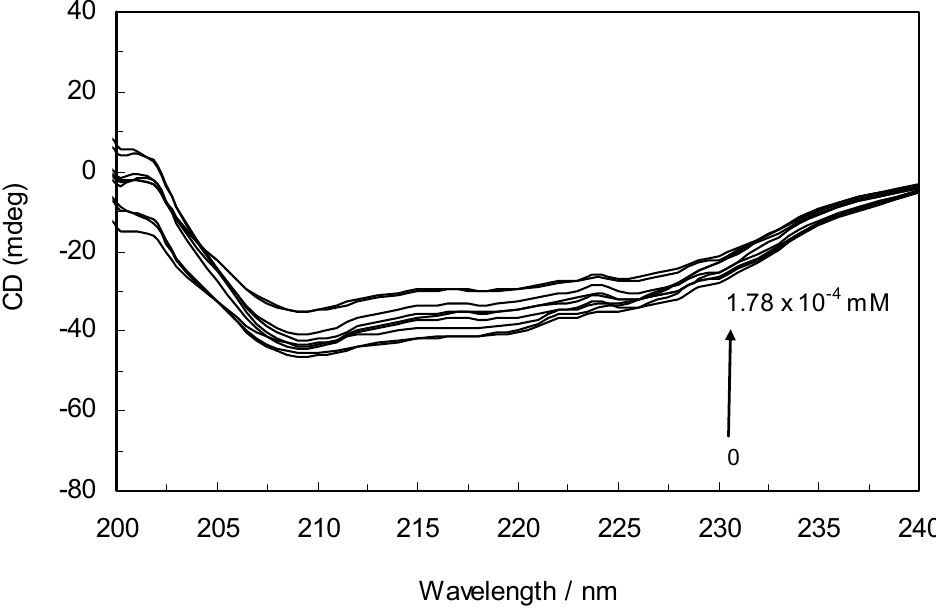
Figure 6. Far-UV CD spectra of hTf in the absence and presence of ROP. pH 7.4 and T = 298 K. [hTf] = 3.8 × 10 − 3 mM. The concentrations of ROP ranged from 0 to 1.78 × 10 − 4